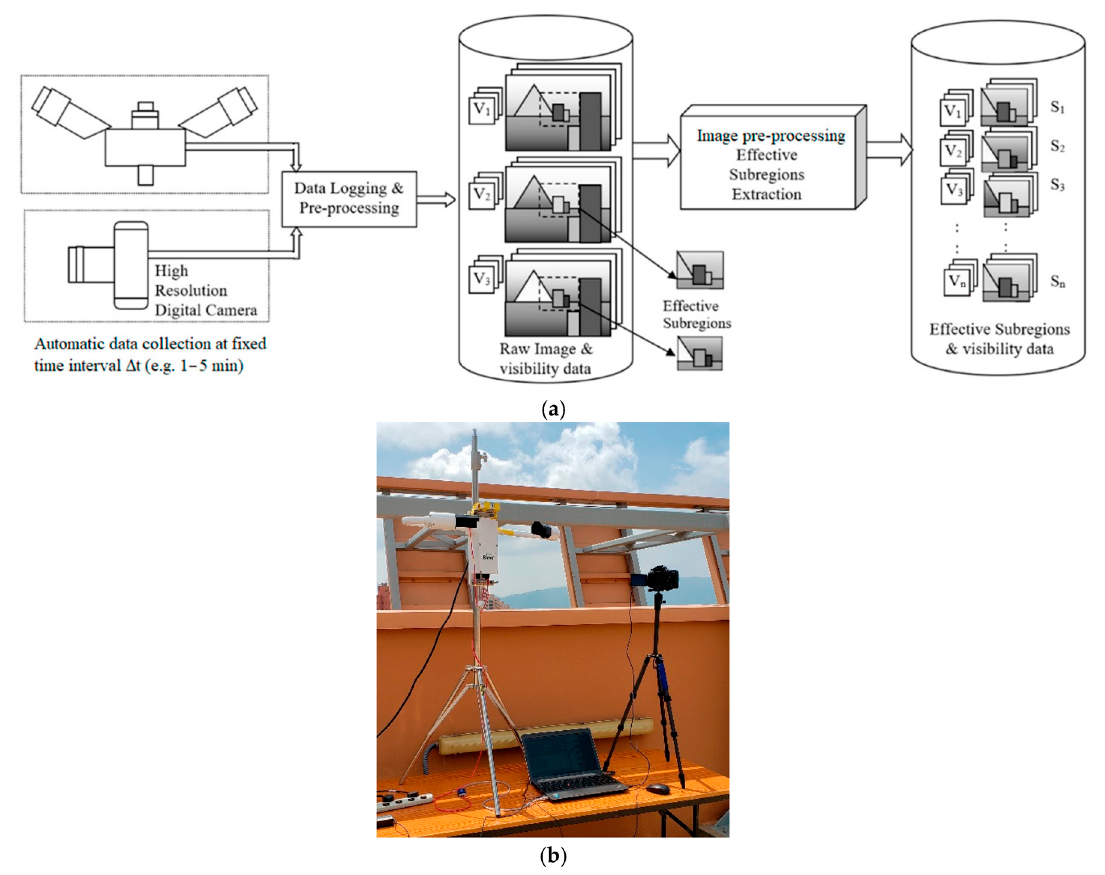
Figure 3. ( a ) Block Diagram for Visibility Monitoring System (108 samples/ day × 62 days = 6696). ( b ) Equipment Testing at campus site.